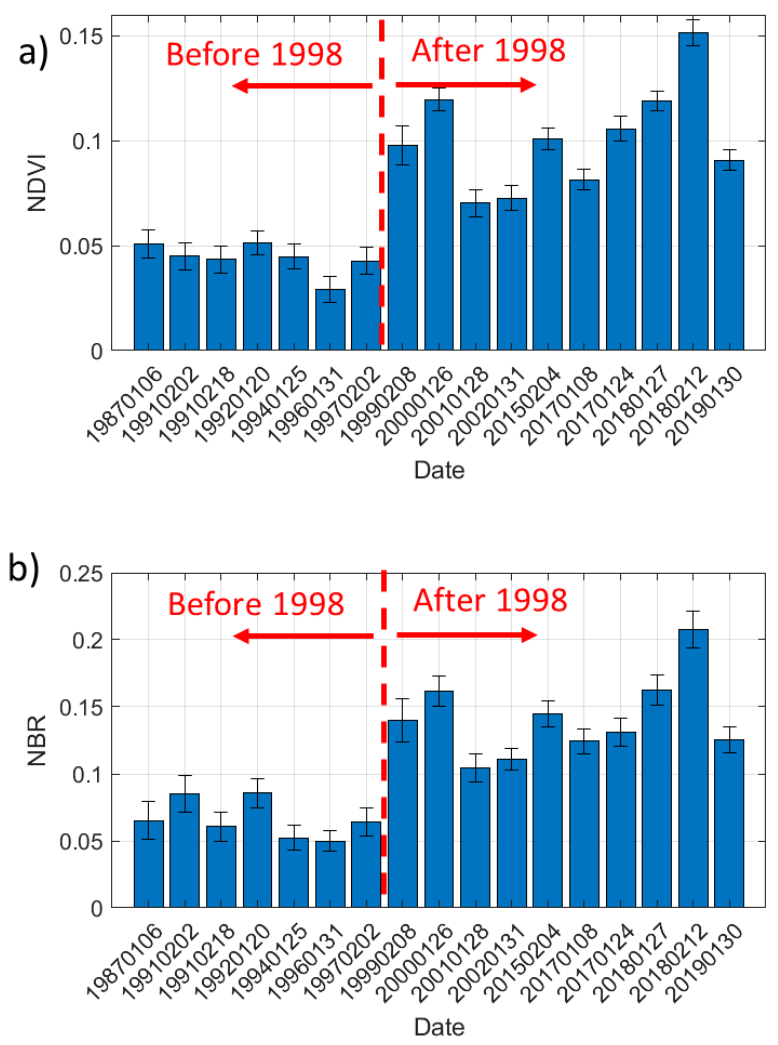
Figure 9. Temporal evolution of the difference in mean between NF and HMCF sites for ( a ) NDVI and ( b ) NBR. The error bars in the graph were estimated from the standard deviations from NF and HMCF sites. Dates are shown in year, month, and day for the Landsat imagery used to derive NDVI and NBR.